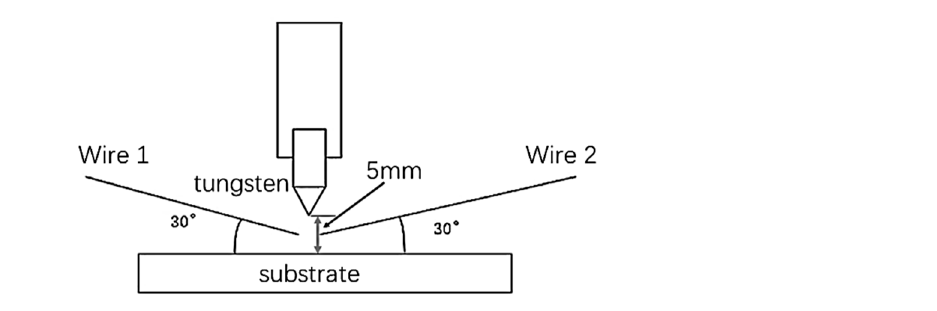
Figure 1. The position between tungsten and wire (horizontal parallel wire feeding of sample 3). Table 2. The process parameters for 308/Q345 additive manufacturing with GTAW.